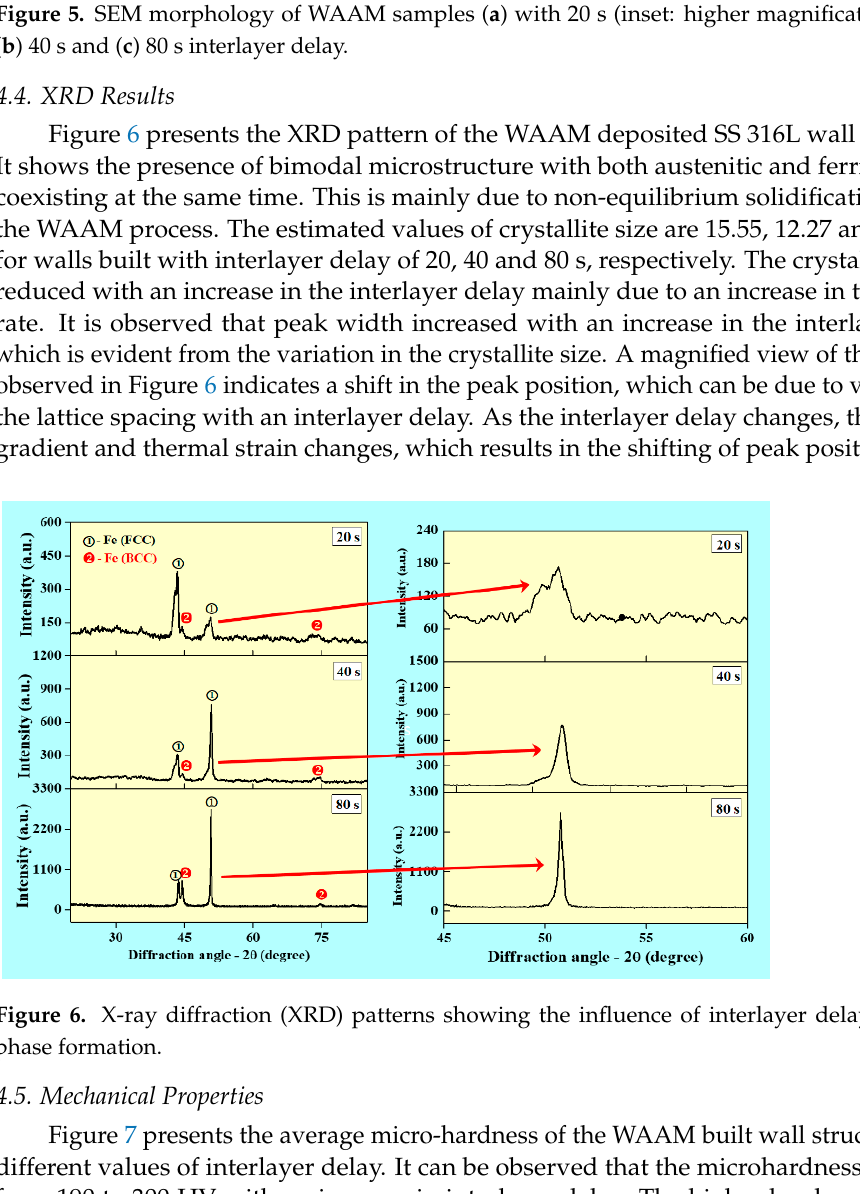
Figure 7. Vickers micro-hardness data as a function of interlayer delay. Compression studies are carried out to investigate the impact of interlayer delay on the compressive characteristics of the wall structures (Figure 8). It is observed that higher strength values are observed for walls built with an interlayer delay of 80 s samples. This is mainly due to the finer grain structure observed in the walls built with higher interlayer delay. In addition, the higher density of the walls built with higher interlay delay also influences the strength values [34–37].